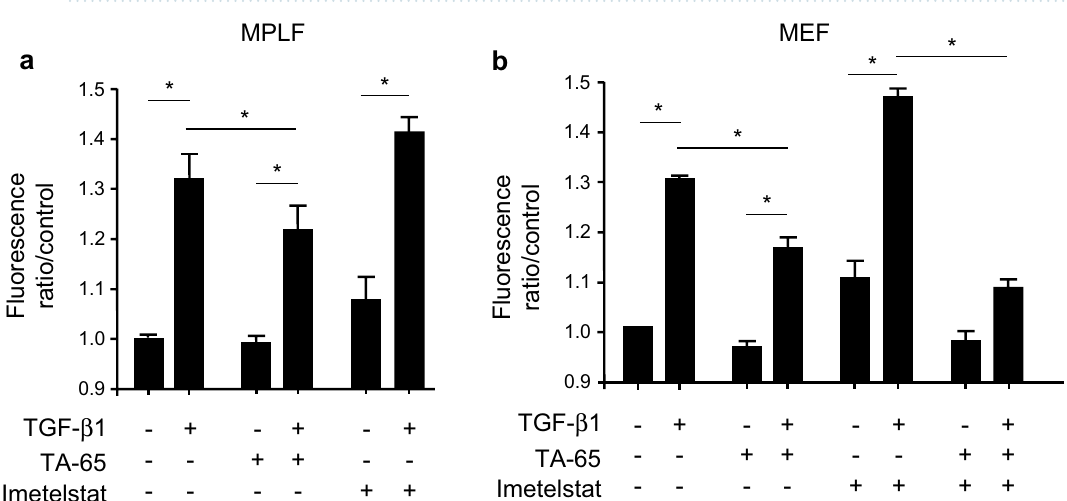
Figure 5. Effects of TA-65 on TGF-β1-induced ROS production in vitro. Mouse primary lung fibroblasts (MPLF) and MEF cells were pre-treated with TA-65 (2 µM) or Imetelstat (1 µM) during 24 h, followed by TGF-β treatment (10 ng/mL) for 48 h. Quantification of intracellular reactive oxygen species ( ROS) production by measuring H2-DCFH-DA (2,7-dichlorofluorescein diacetate) oxidation in MPLF ( a ) and MEF ( b ). n = 3–4 samples per group. Data are presented as mean ± SEM. *p < fibroblast-to-myofibroblast differentiation in response to TGF-β1 in lung primary fibroblast in vitro. Postulating TGF-β1 expressed by bronchial epithelial cells after CS exposure may play a significant role in peribronchial fibro-